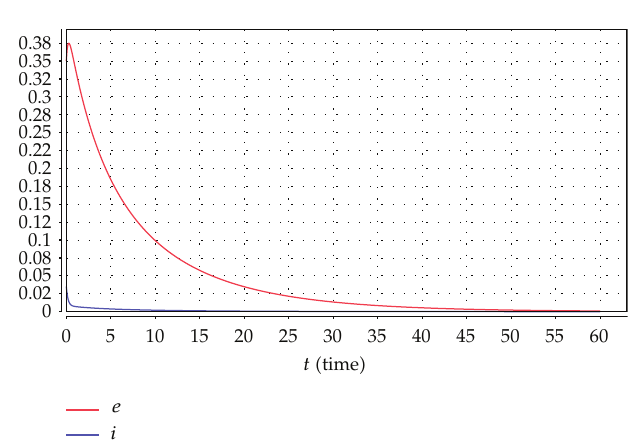
Figure 2: Phase plot of e versus i showing the disease-free equilibrium Q 0 which is stable when R 0 < 1 for the parameter values α (cid:8) 0 . 3 , b (cid:8) 0 . 0143 , β (cid:8) 13 , δ (cid:8) 0 . 1 , γ 1 (cid:8) 2 , γ 2 (cid:8) 3 , k (cid:8) 0 , e 0 (cid:8) 0 . 35 , i 0 (cid:8) 0 . 035. Based on these parameters, R 0 ≈ 0 . 77 < 1.